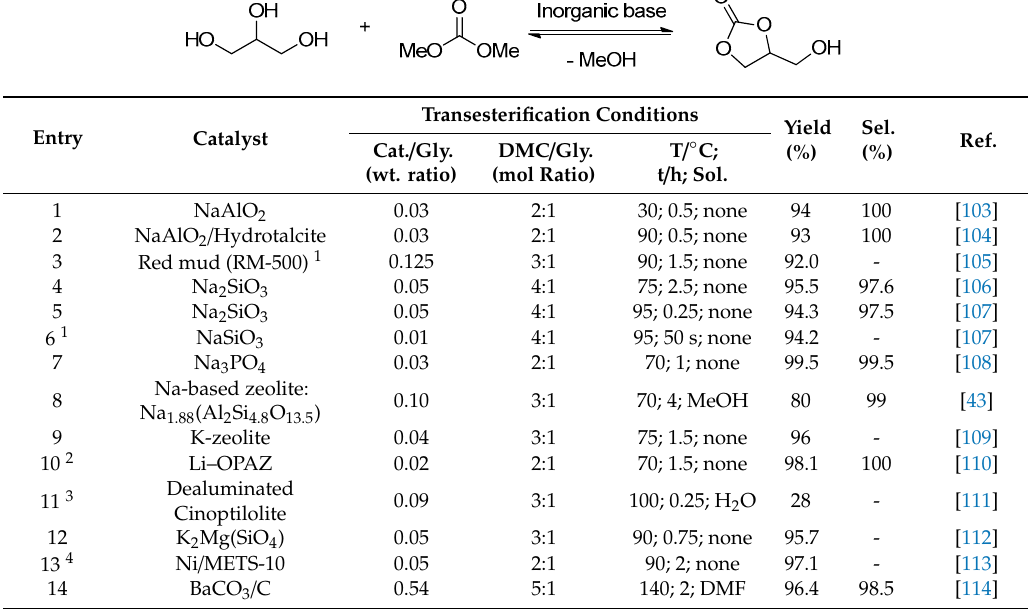
Table 5. Other inorganic base catalyzed transesterification of